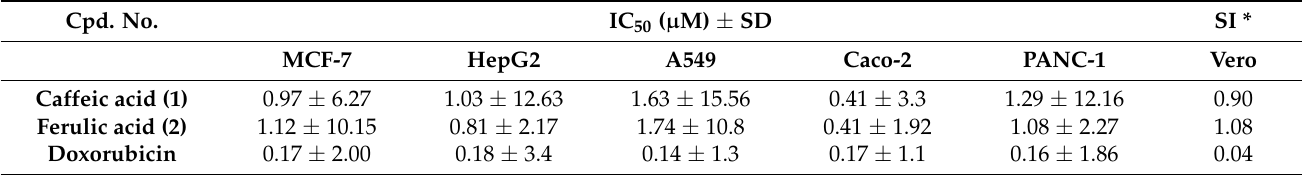
Table 2. IC 50 of the parent compounds and doxorubicin on different cancer cell lines. Results are the average of